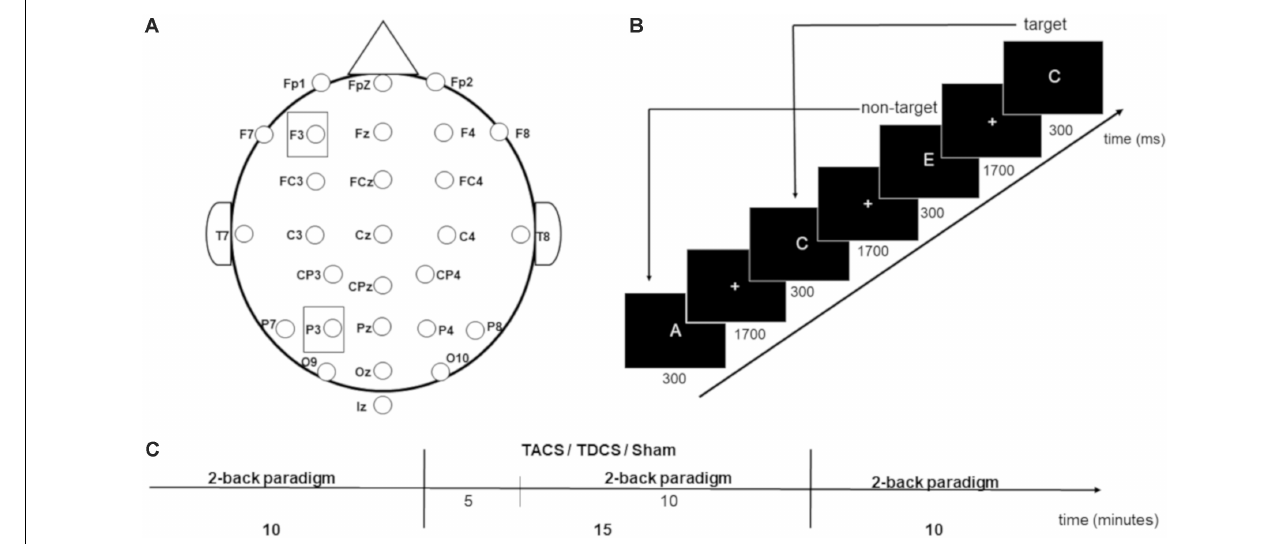
FIGURE 1 | (A) Electrode placement. (B) 2-back working memory task. (C) Procedure during one